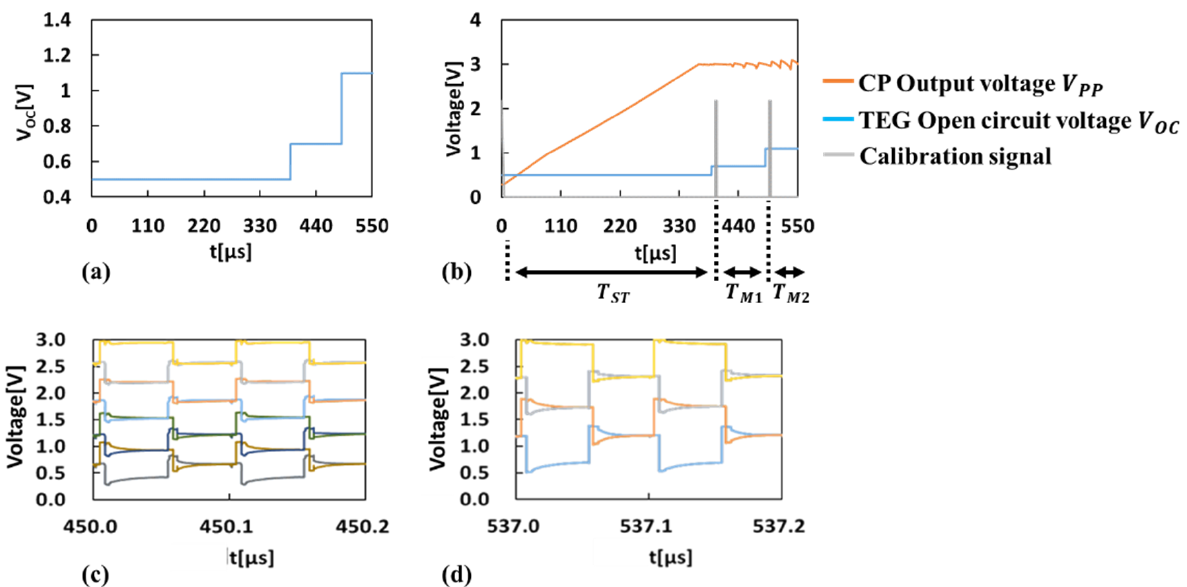
Figure 13. Input voltage V OC ( a ), V PP , V OC , and calibration signal ( b ), 16 capacitor voltages in T M1 ( c ), and 16 capacitor voltages in T M2 ( d ).